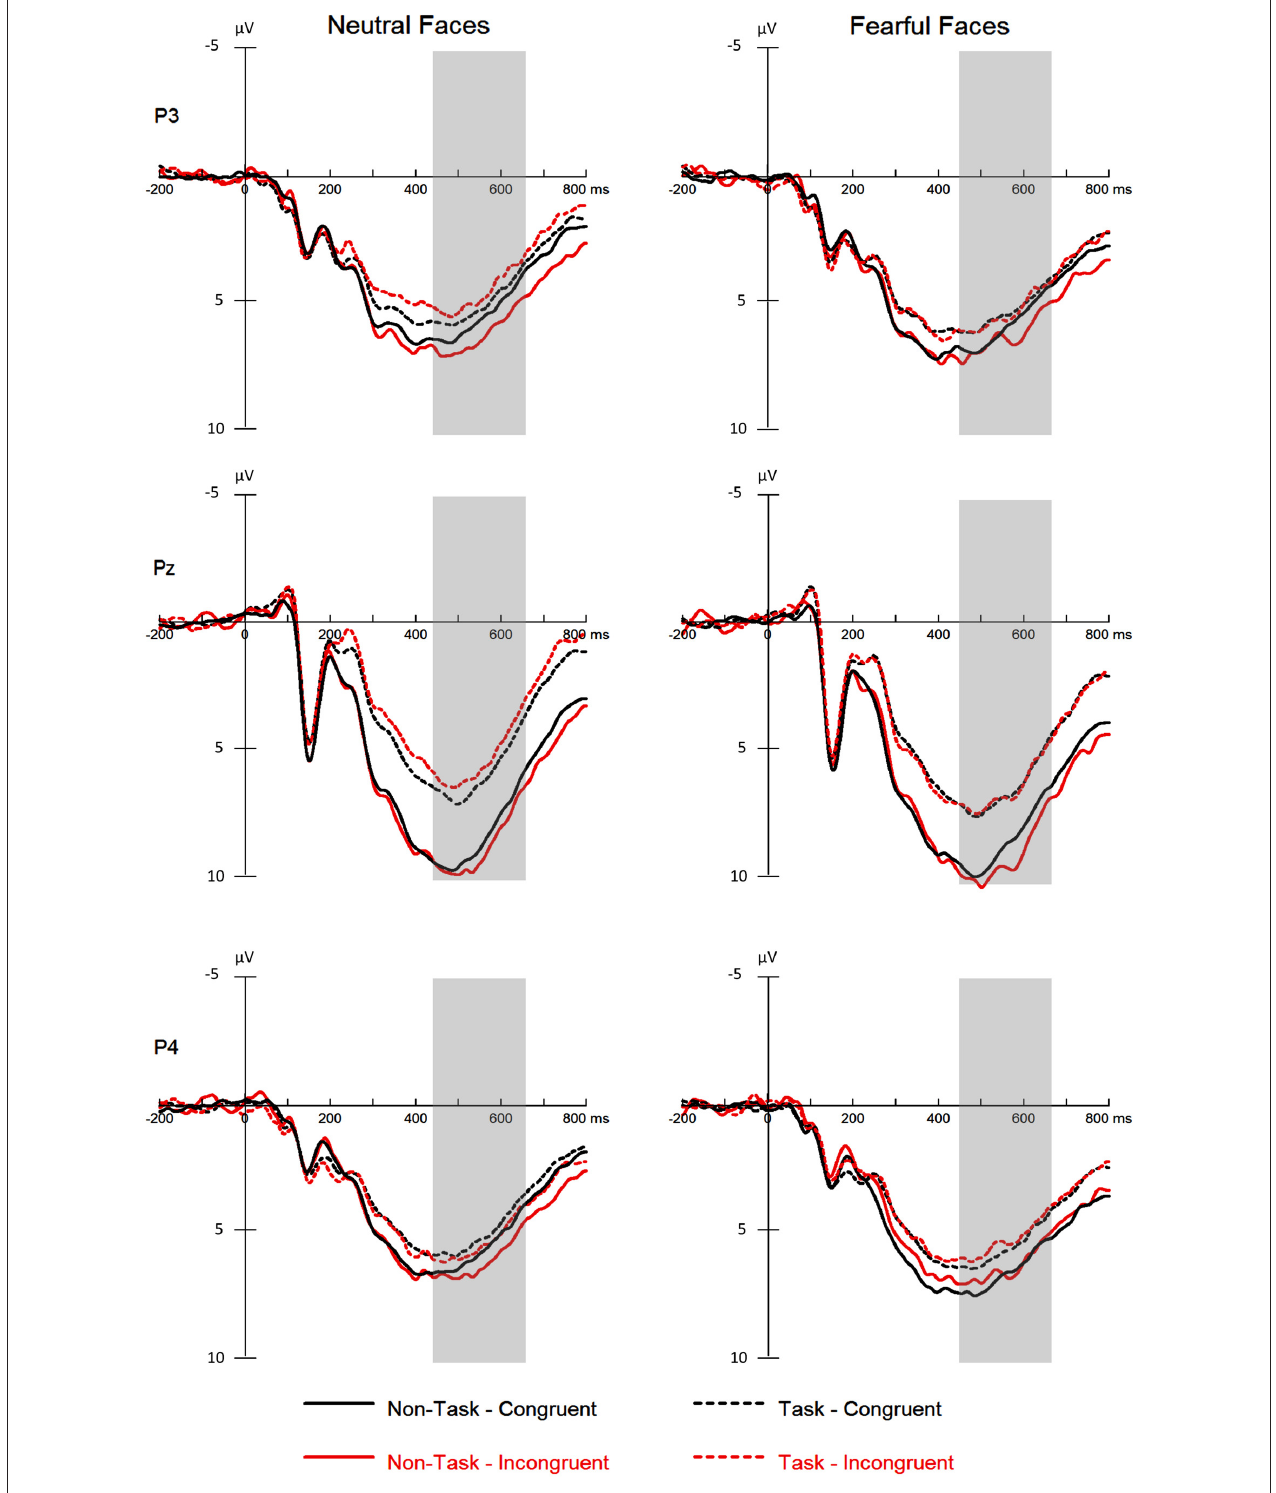
FIGURE 4 | ERPs at the parietal electrodes (P3, Pz, and P4) for all the experimental conditions. Shaded areas correspond to the analysis window for the P3 (450–650ms).